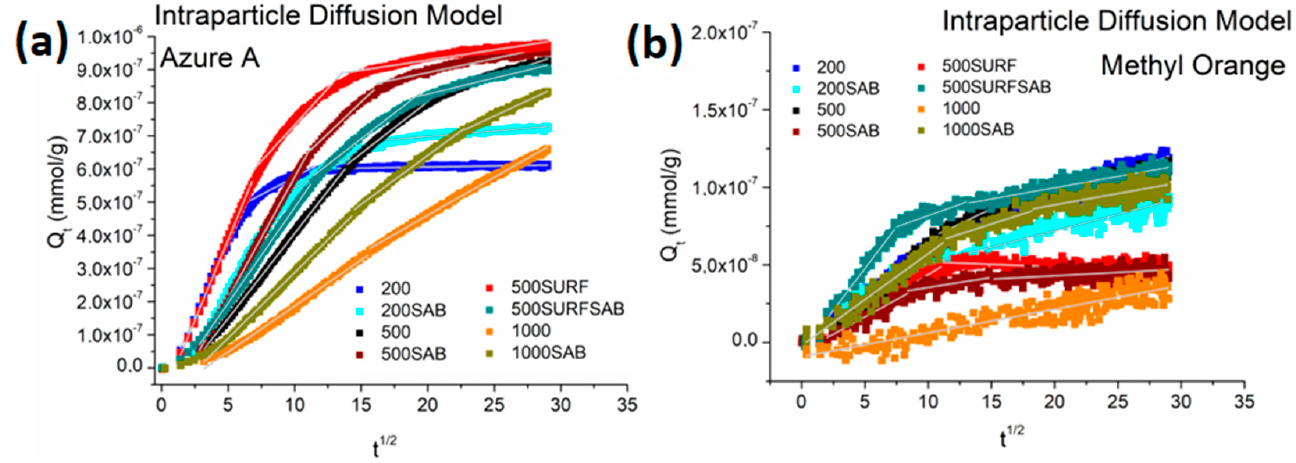
Figure 11. Application of the intraparticle diffusion model onto membranes for AZ ( a ) and MO ( b ).